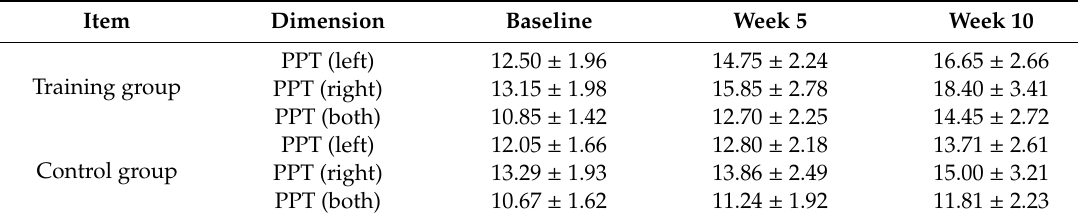
Table 8. PPT scores before and after intervention ( N = 41, and X ± SD).